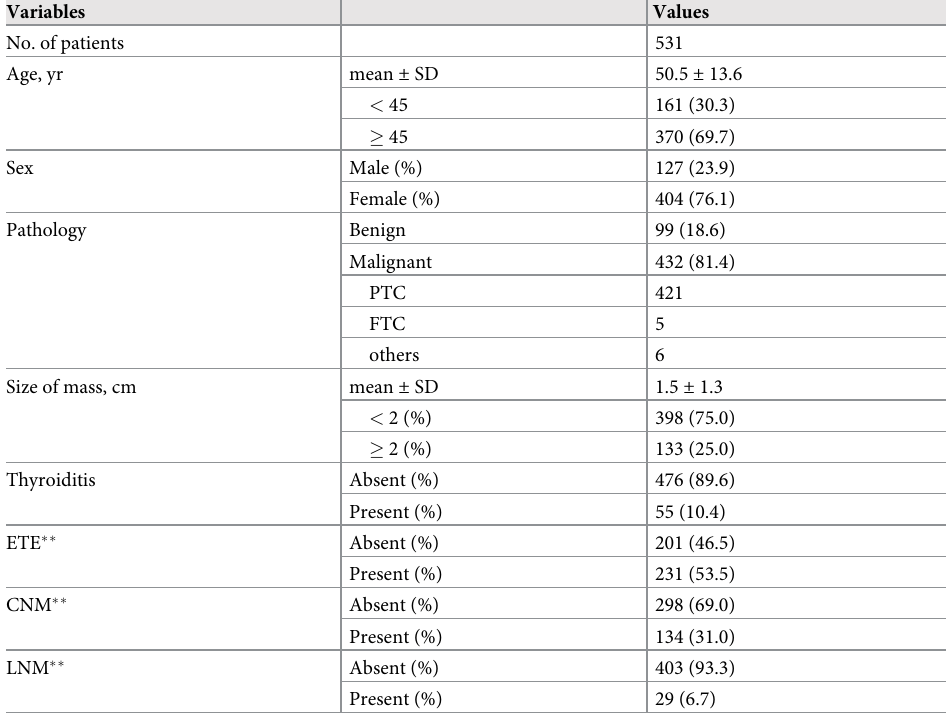
Table 1. Patients’